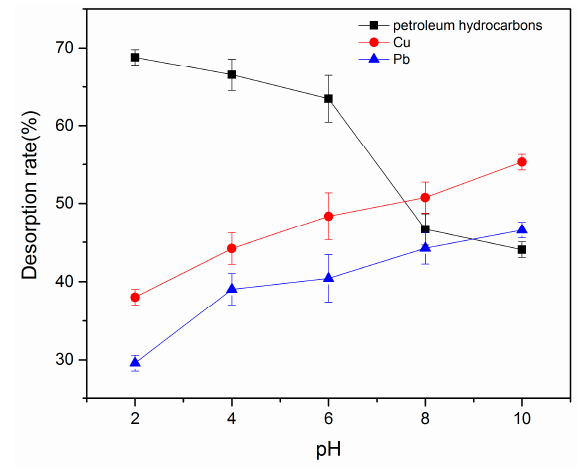
Figure 5. Effect of pH on desorption.